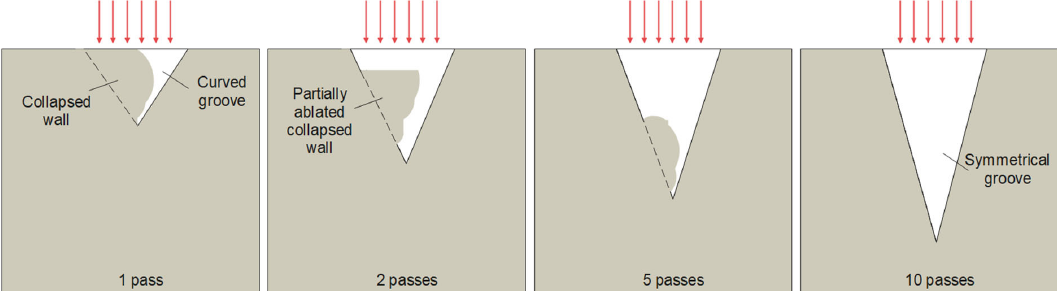
Figure 7. Schematical explanation of the formation of the curved groove with a 2 μ m hatch pitch. At large hatch pitches (15 and 20 μ m), the grooves are less well ‐ defined and traces of remaining material can be seen on several cross-sections. Figure 8 highlights the differences in groove profiles.